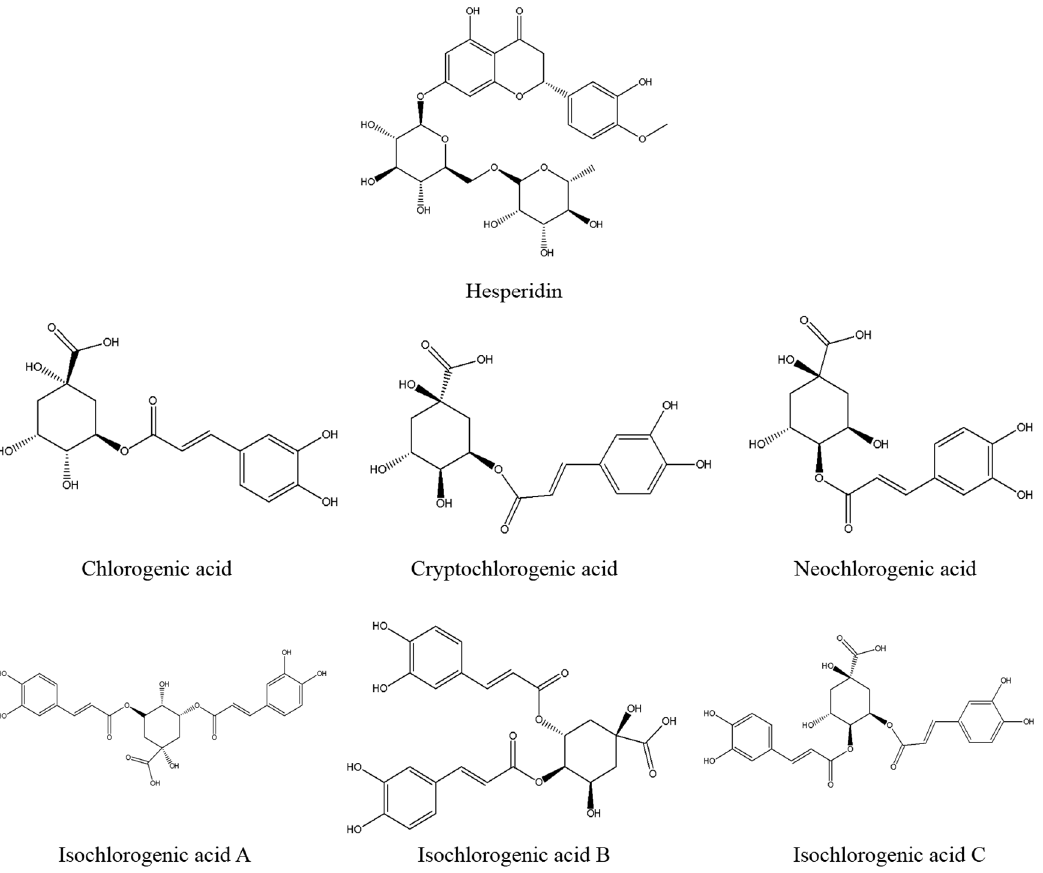
Figure 2. The chemical structural formulas of seven known compounds in ZZX.